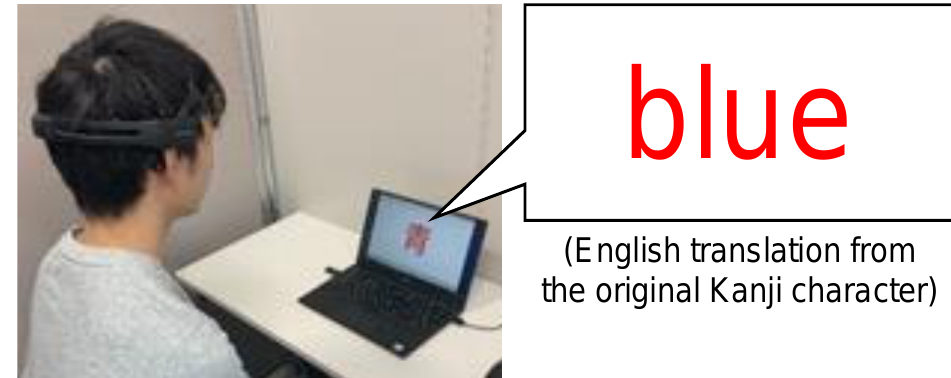
Figure 2. Experiment scene where a Kanji means “blue” is indicated on the screen in red ink.